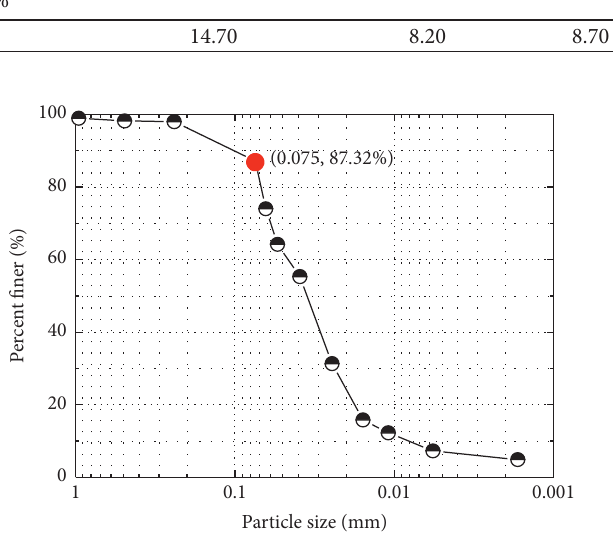
Figure 3: Grain size distribution of soils. Table 2: Properties and composition of permeable polyurethane.